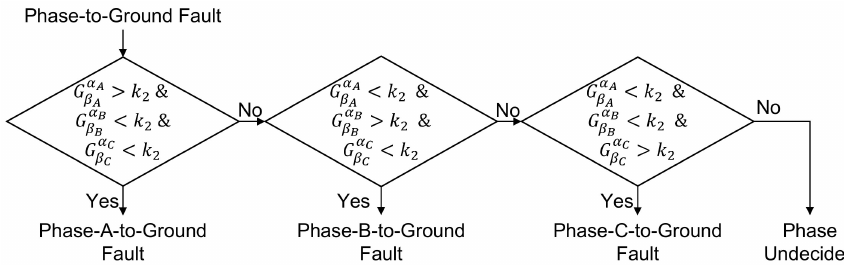
Figure A4. Phase-to-Ground fault identification [21].